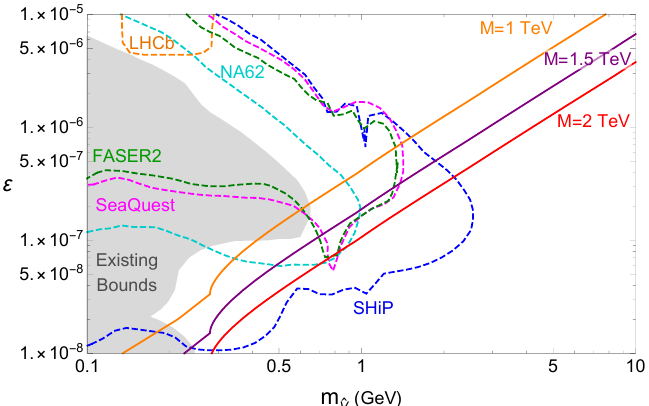
Figure 7 . Illustration of where the ^ V lies in the dark photon parameter space (solid lines), for three M benchmarks. Also shown are current exclusions (gray-shaded region) and the projected reach of future experimental probes (dashed